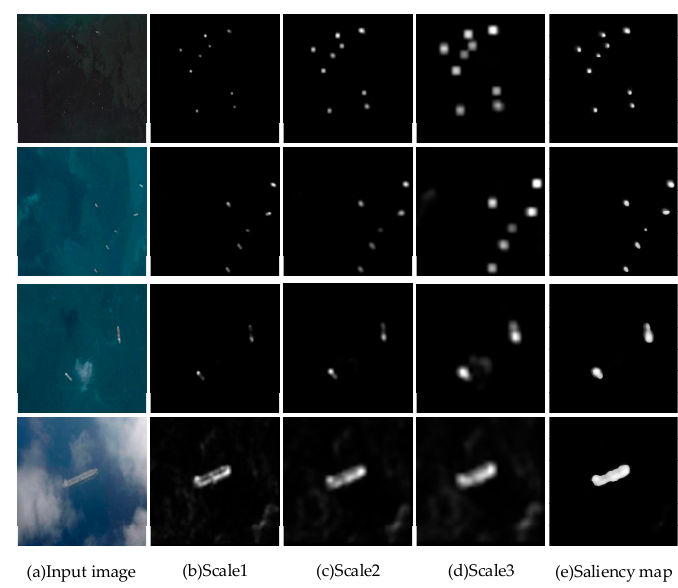
Figure 4. ( a ) A set of images containing the different size of targets. ( b – d ) Estimated saliency maps obtained at different scales (patch size parameter n = 4, 8, 16 respectively) ( e ) Final saliency map based on the multi-layer cellular automata described in the text. By performing multi-scale saliency, our model is robust in the presence of target size changes. In addition, it can pop out the targets accurately and suppress the cluttered background effectively.